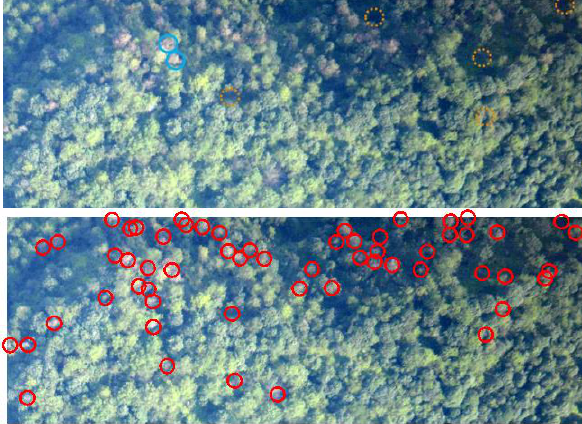
Figure 7. Distribution of the diseased trees (from top to bottom: RGB image, image marked by red